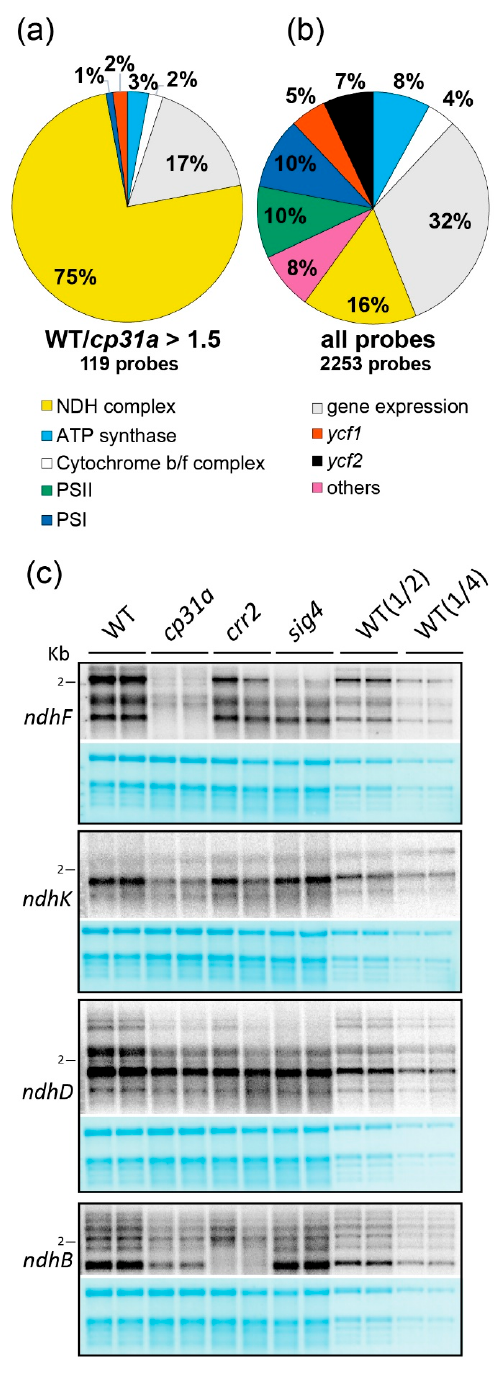
Figure 2. Analysis of RNA accumulation in cp31a mutants. ( a ) Summary of microarray analyses of 14 days old WT and cp31a mutant seedlings. Relative abundance of exon probes showing at least 1.5-fold stronger signals in WT versus cp31a mutants. Three replicate microarray hybridizations were analyzed and assigned to different gene categories. All results are presented in Supplementary Table S3. ( b ) Relative distribution of all exon probes on the microarray to different gene categories. ( c ) RNA gel blot analysis of 14 days old Arabidopsis seedlings. A quantity of 4 µg RNA from WT, cp31a mutants, and two control mutants ( crr2 and sig4 ) together with dilutions of WT samples (1 / 2 and 1 / 4) were probed with radiolabeled RNA probes against four di ff erent ndh genes. The resulting autoradiographs are always shown with the corresponding methylene blue stains of the membranes (below). The 2 kb marker band is shown as a